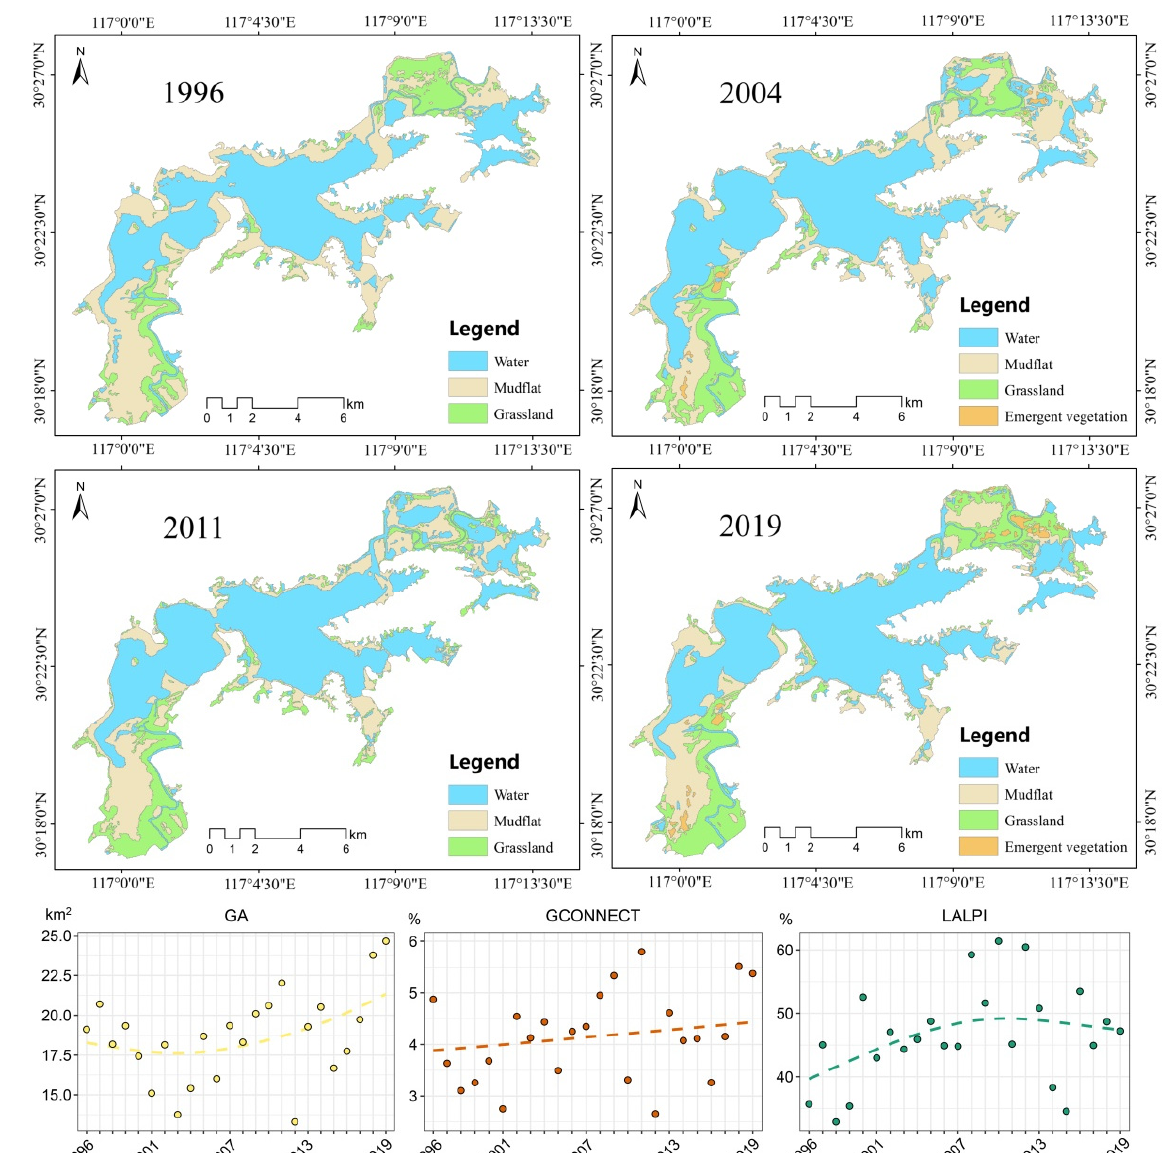
Figure 3. Changes to the landscape of Shengjin Lake National Reserve during the last twenty-four years. GA = grassland area; GCONNECT = connectivity of grassland area; LASIMPEVE = Simpson’s evenness index of lake area.